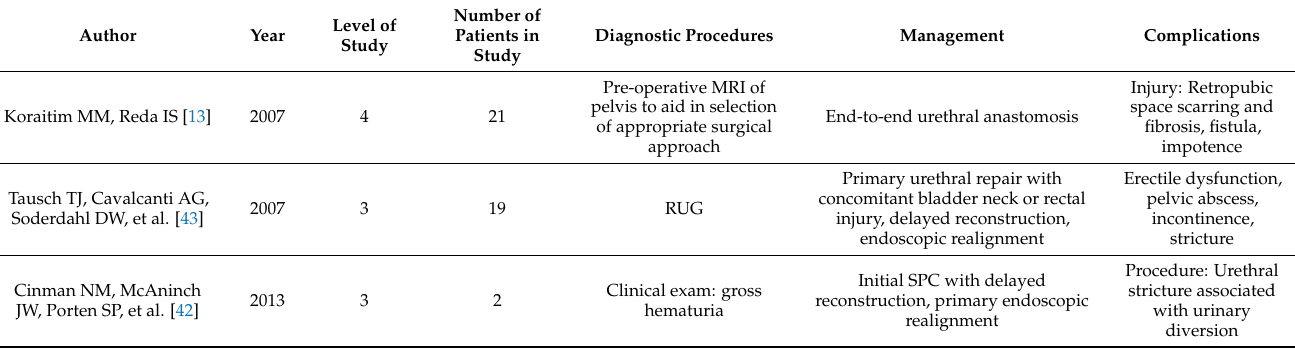
Table 3. Penetrating Posterior Urethral